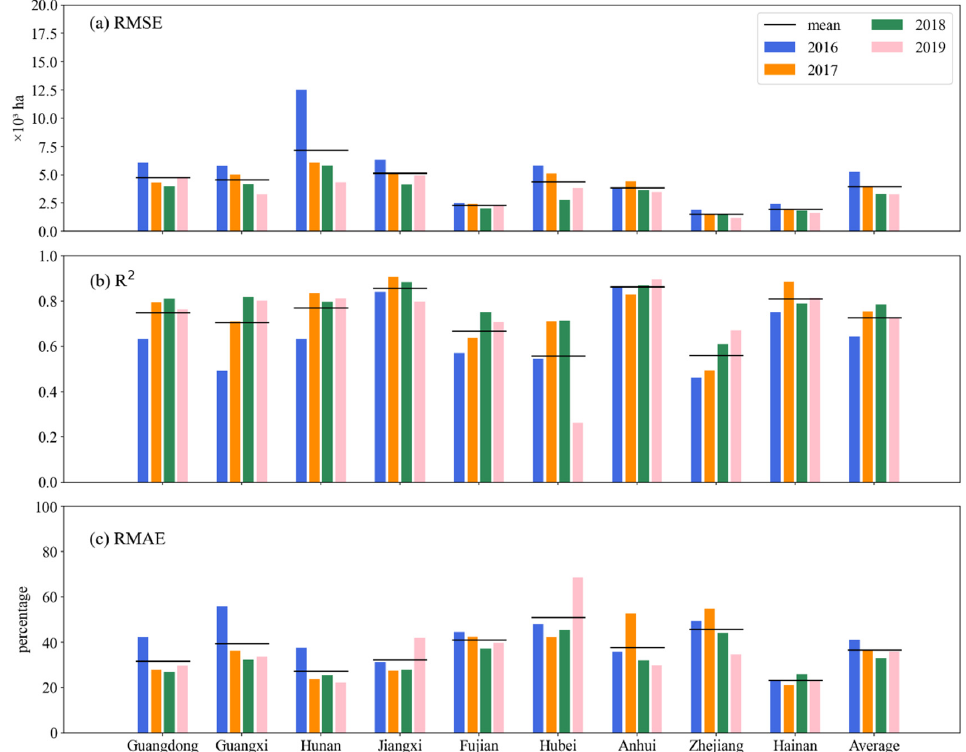
Figure 8. The comparison between identified planting areas of late rice and agricultural census areas at county-level for 2016–2019 in all nine investigated provinces.